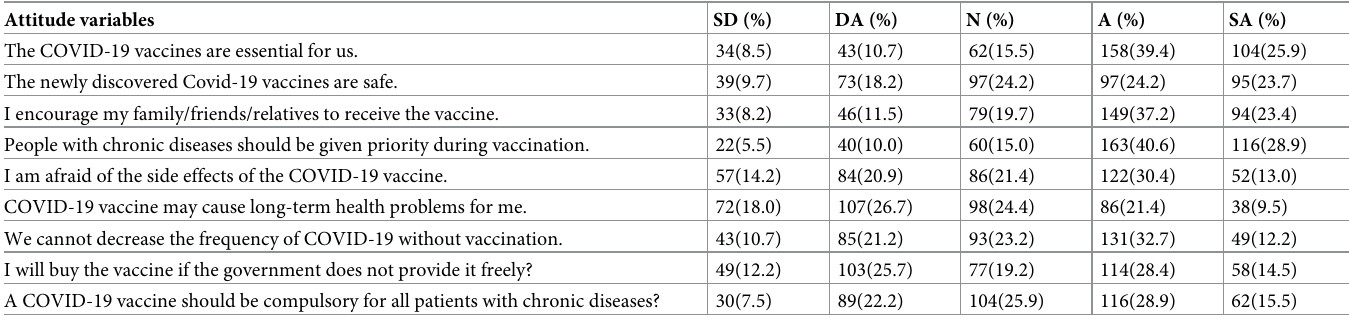
Table 3. Attitude towards COVID-19